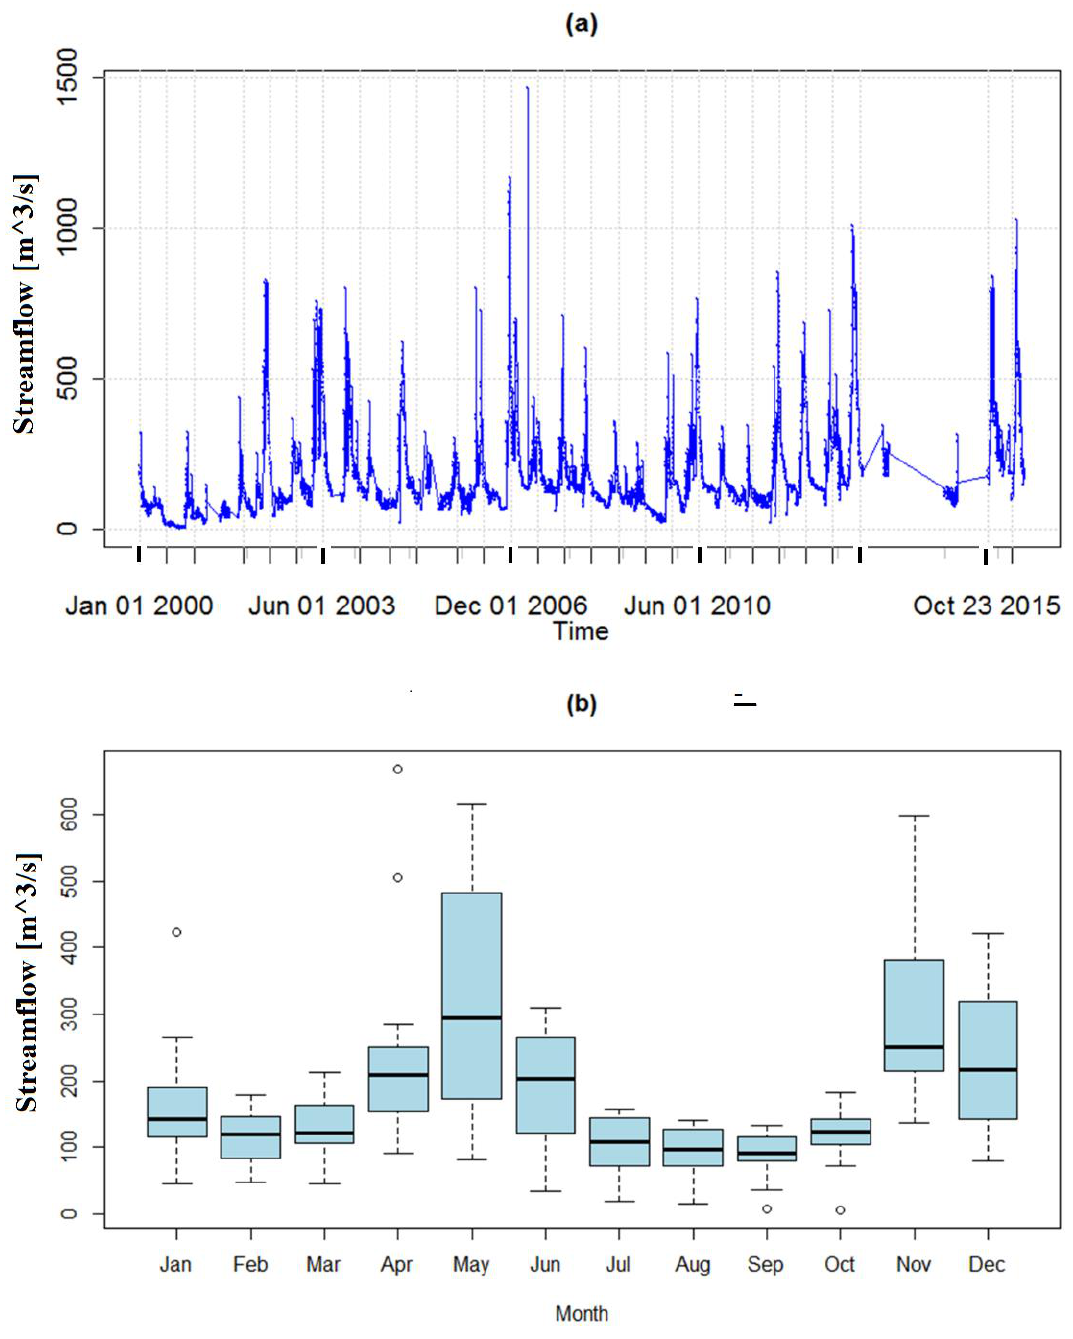
Figure 3. ( a ) Historical daily discharge measurements and ( b ) distribution of median monthly Tana River streamflows (period 2000–2016) based on daily readings at Garissa gauging station. Outliers are denoted by “°”.